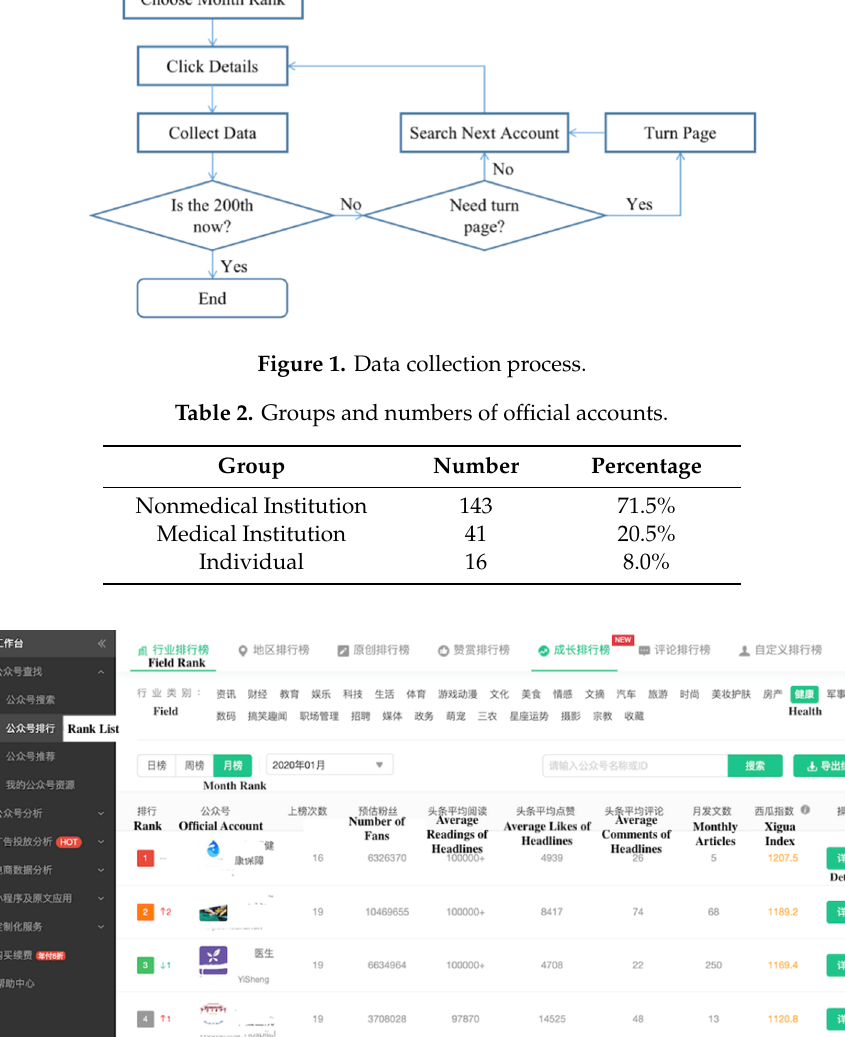
Table 2. Groups and numbers of official accounts .